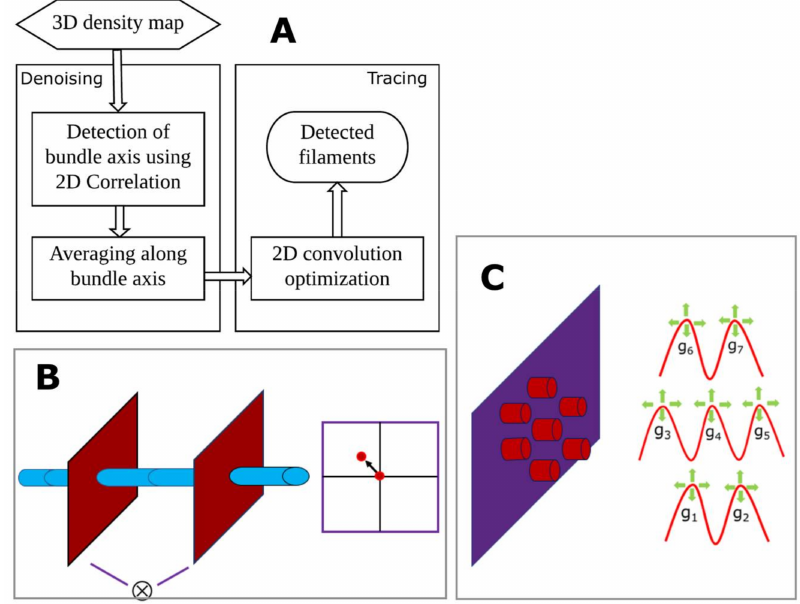
Figure 7. The design of BundleTrac. ( A ) Overall steps; ( B ) detection of the bundle axis using 2D cross-correlation; ( C ) 2D convolutional optimization using seven hexagonally arranged Gaussian